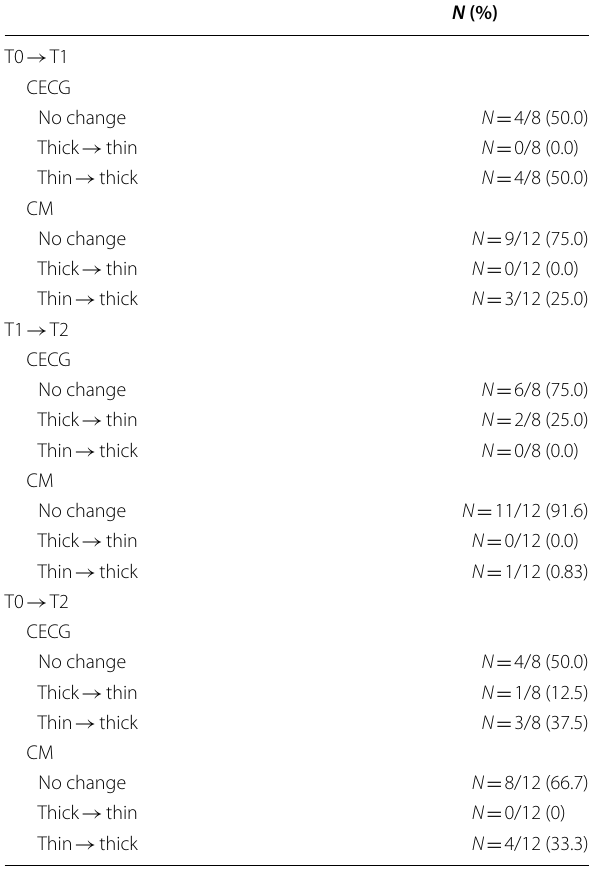
Table 1 Phenotype changes per group and the phenotype over time illustrated by absolute and relative frequencies